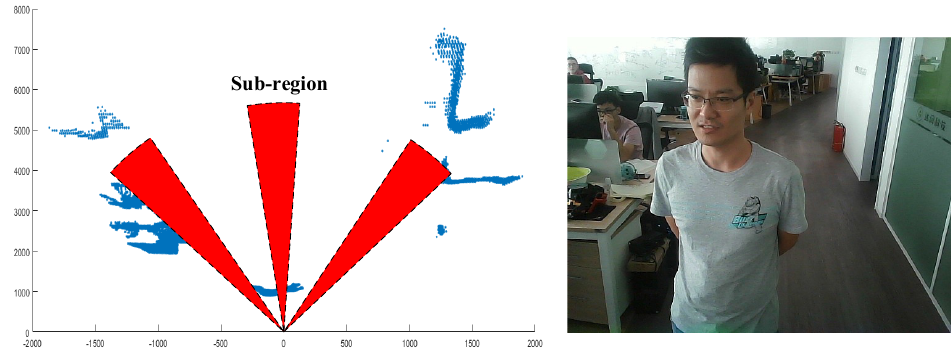
Figure 6. Point cloud that projects on the plane X w OZ w